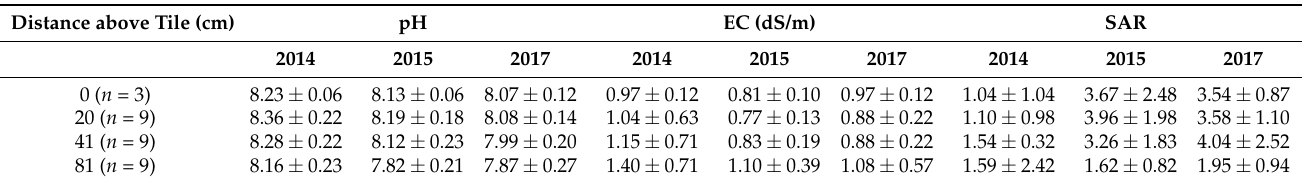
Table 5. Mean pH, electroconductivity (EC), and sodium adsorption ratio (SAR) in relation to the tile position in 2014, 2015, and 2017. Sample size (n) is given next to each row title and standard deviations are listed for each value. Distance above Tile (cm) pH EC (dS/m) SAR 0 ( n =